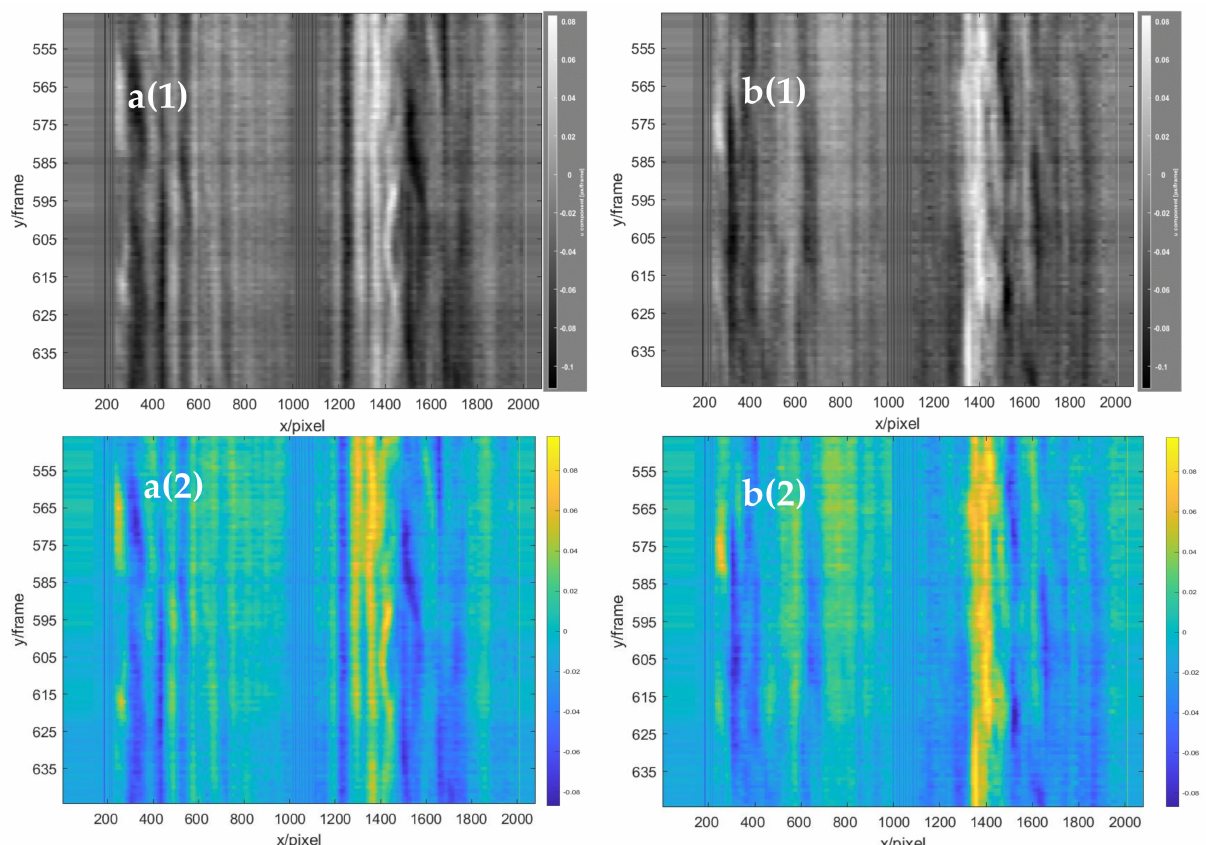
Figure 18. The stacked baseline analysis graphs in the horizontal direction of 100 frames. a ( 1 ) Baseline a (gray scale), and a ( 2 ) baseline a (RGB color). b ( 1 ) Baseline b (gray scale), and b ( 2 ) baseline b (RGB